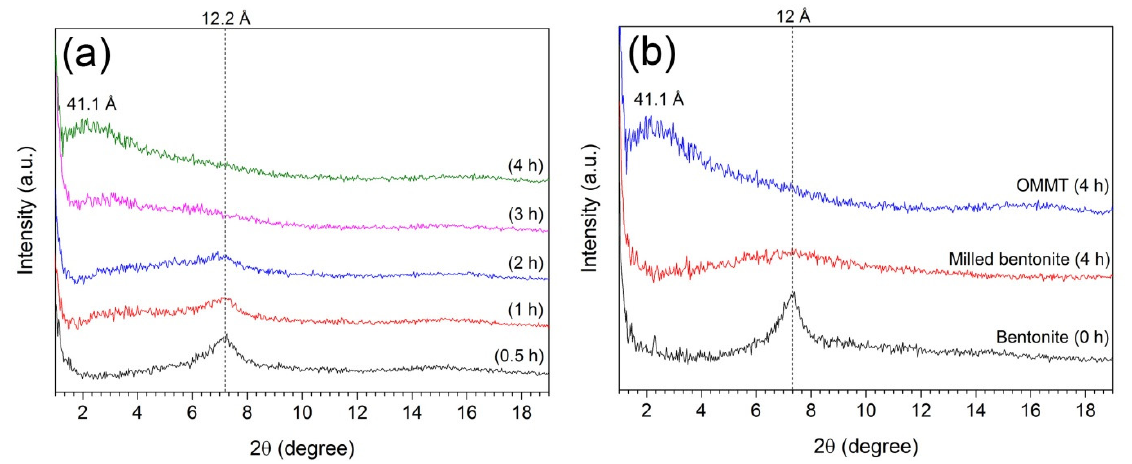
Figure 1. X-ray diffraction patterns of ( a ) the bentonite/gum rosin powder mixture at various milling times and ( b ) the OMMT compared to the pristine and milled bentonite.